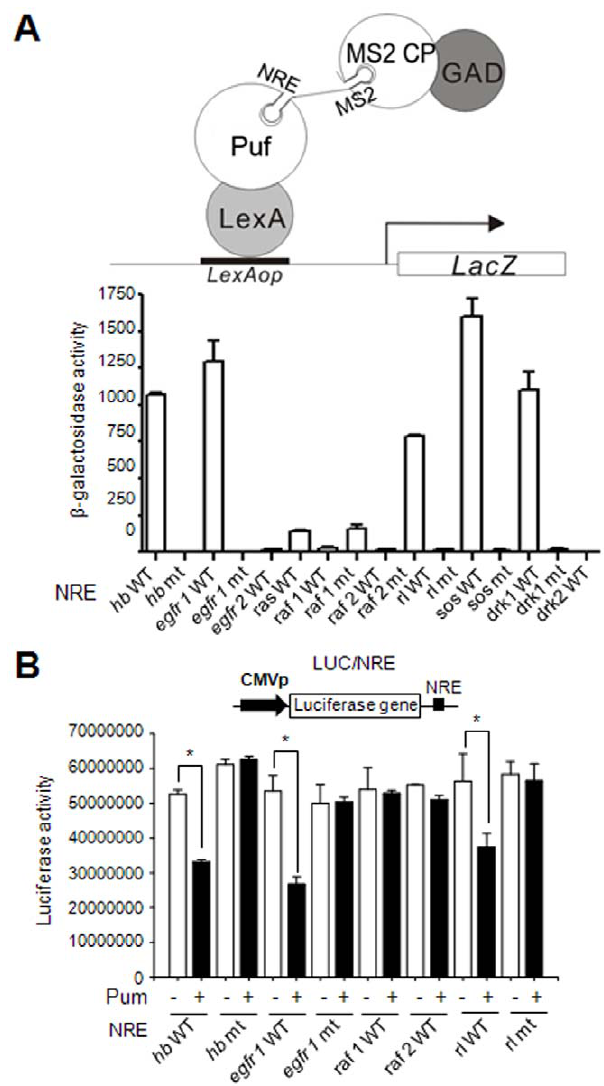
Figure 5. Pum binds to the potential NRE-like sequence of EGFR signaling components. (A) (Upper) Schematic drawing of the yeast three-hybrid assays. An RNA containing the NRE and MS2 sequence recruits both Gal4 transcriptional activation domain (GAD)- MS2 coat protein (CP) fusion protein (GAD-MS2 CP) and lexA DNA binding domain (DBD)-Puf fusion protein (LexA-Puf). The resultant ternary complex leads to the expression of lacZ coding sequence through binding to lexA binding sequence (LexAop). (Lower) Yeast YPH500 cells harboring the lex A op - Lac Z reporter, LexA DBD-Puf and GAD-MS2 CP were transformed with vectors that allow for expression of diverse NRE-MS2 transcripts as indicated. Liquid b -galactosidase assays were carried out for transformants. The mean 6 SD values were obtained from at least three independent experiments and are presented on the Y-axis. (B) (Upper) Schematic diagram of a reporter containing luciferase ( luc ) coding sequence with CMV promoter (black arrow) and NREs (black box) in its 5 9 - and 3 9 -UTR, respectively.